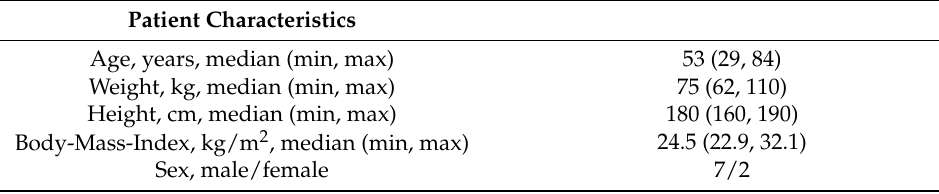
Table 1. Patient